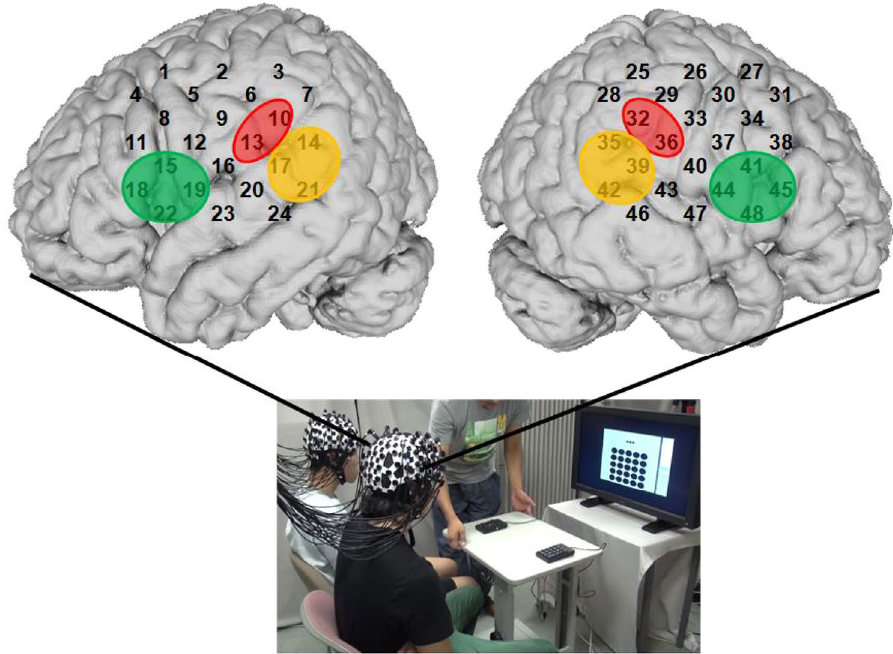
Figure 2. Positions of the 48 channels on one participant’s left and right hemispheres. The bottom picture shows the experimental setting in the present study. The green, red, and yellow overlays cover the bilateral IFG, IPL, and pSTS, respectively. IFG: inferior frontal gyrus; IPL: inferior parietal lobule; pSTS: posterior superior temporal